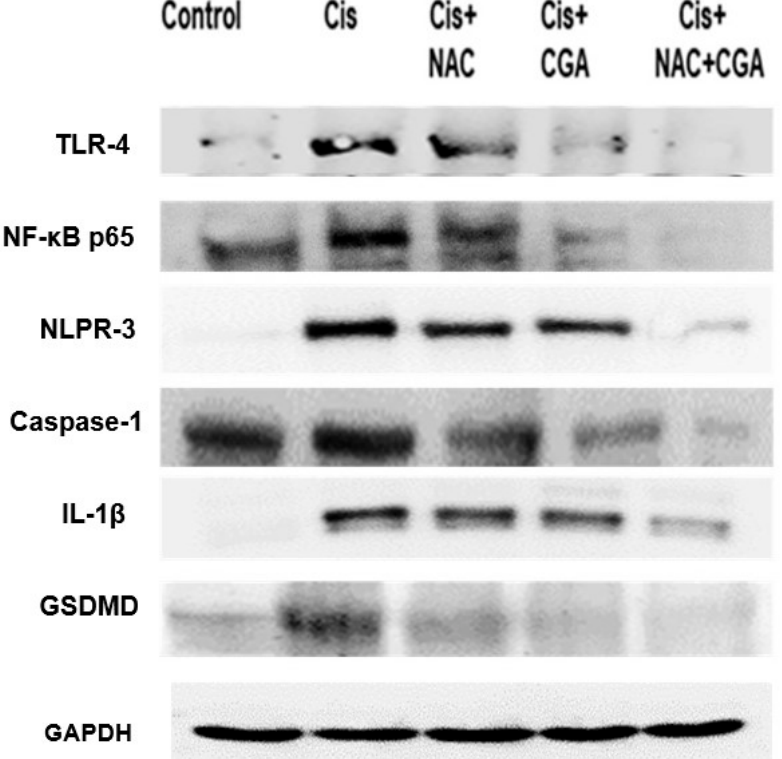
Figure 3. Effect of NAC and/or CGA on the TLR4/NLPR3/IL-1 β and caspase-1/GSDMD Signaling Pathway in Kidney Tissue of Rats. Representatives immunoblot of protein level of TLR4, NF- κ B, NLPR3, caspase-1, IL-1 β , and GSDMD in kidney tissues. Sample proteins were immunoblotted with the antibodies’ “upper panels” and after stripping with GAPDH antibody as a loading control “lower panel.” Control: normal rats; Cis: Cisplatin (7 mg/kg, IP) injected rats; Cis + NAC: Cisplatin injected rats treated with NAC (250 mg/kg/day p.o.) one week before and after cisplatin injection; Cis + CGA: Cisplatin-injected rats treated with CGA (20 mg/kg/day p.o.) one week before and after cisplatin injection; Cis + NAC + CGA: Cisplatin-injected rats treated with NAC (250 mg/kg/day p.o.) and CGA (20 mg/kg/day p.o.) one week before and after cisplatin injection. NAC: N-acetylcysteine; CGA: Chlorogenic acid; TLR4: Toll-4 receptors; NF- κ B: Nuclear factor kappa B; NLPR3: Inflammasomes; IL-1 β : Interleukin-1 beta; GSDMD: Gasdermin